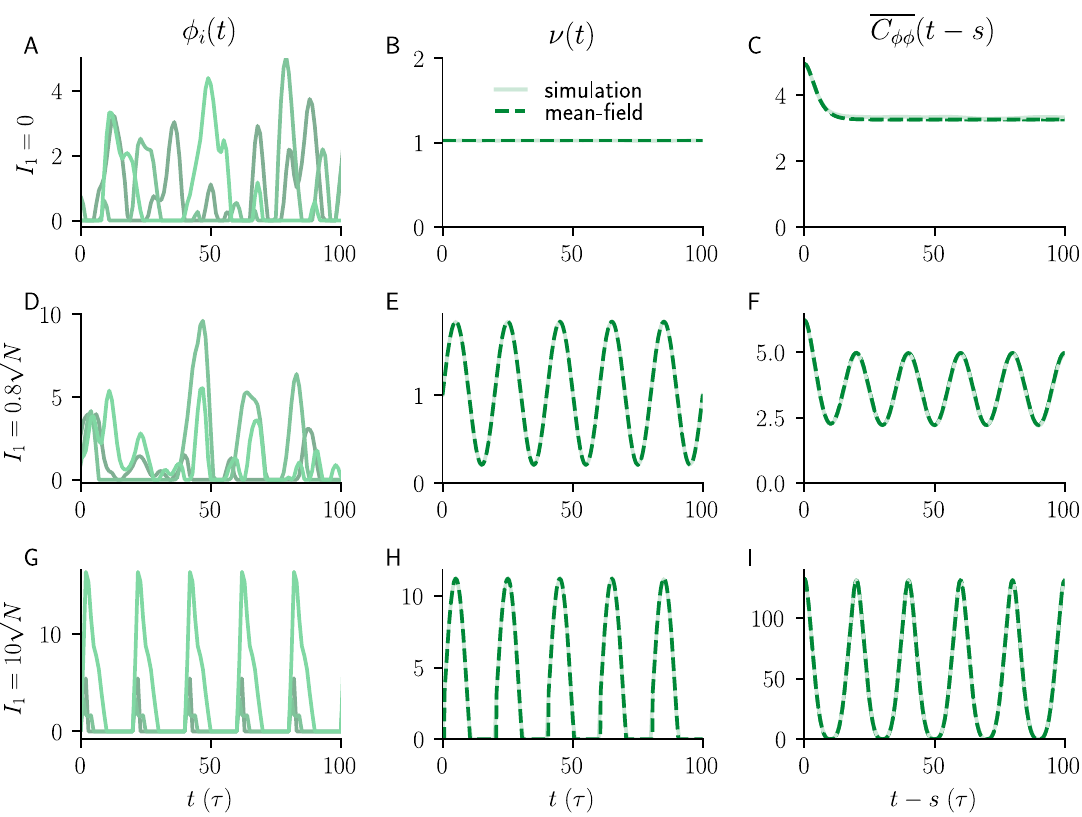
Fig 8. Activity, population firing rate and autocorrelations of balanced networks with common input. A) Firing rates ϕ i ( t ) = ϕ ( h i ( t )) of three example units. B) Mean population firing rate ν ( t ). C) Time-averaged two-time autocorrelation function (Eq 5) as a function of time difference with no external input ( I 1 = 0). D-F) Same as A-C but for input amplitude I G-I Same as A-C but for stronger input ( I Dashed lines (middle and right columns) are results of non-stationary DMFT, full lines are median across 10 network realizations. Model parameters: N = 5000, g = 2, f = 0.05/ τ , I 0 = J 0 = 1.